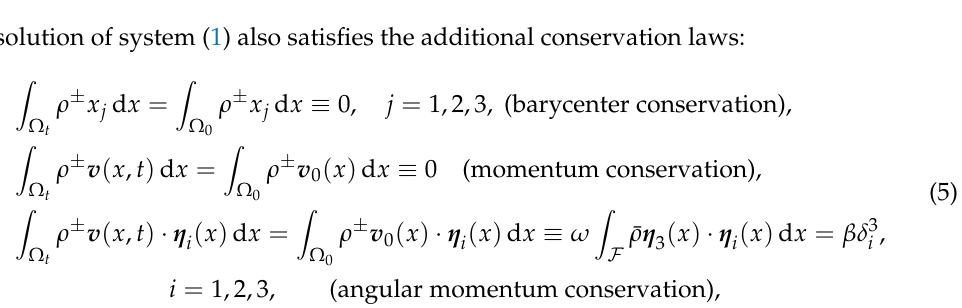
Figure 1. Two–phase